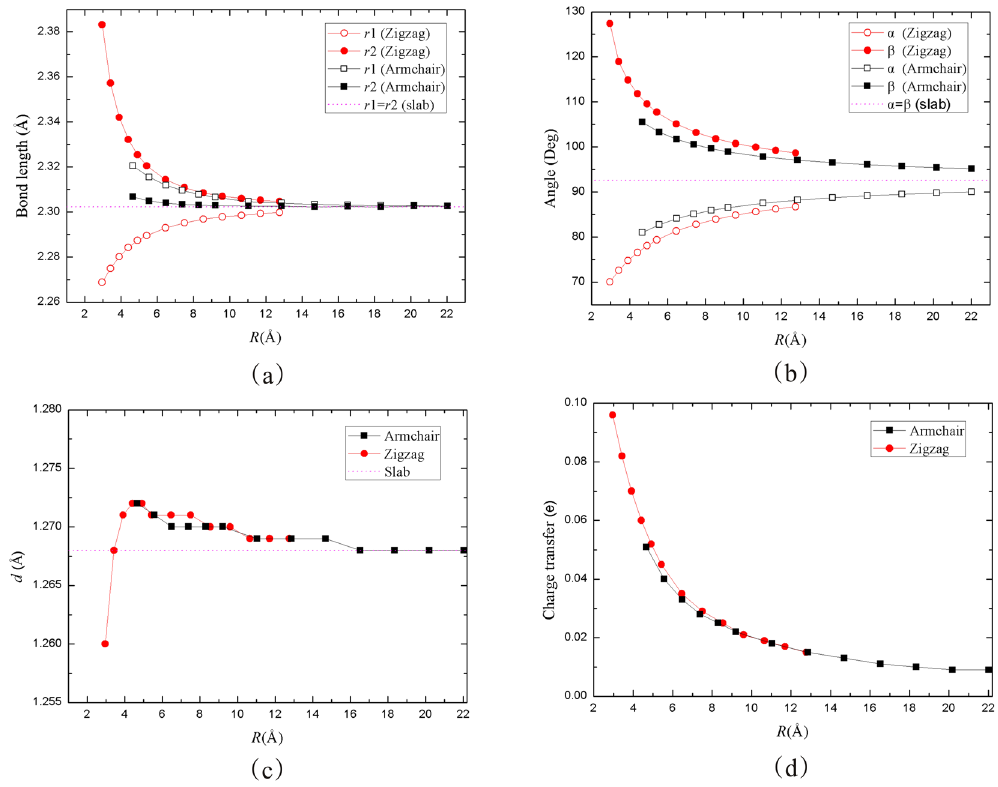
Figure 4. ( a ) Bond lengths of the armchair and zigzag blue PNTs are plotted versus tube radius. ( b ) Angles of two types of blue PNTs as a function of radius. ( c ) Dependence of puckered-layer distance d of blue PNTs with different radius. ( d ) The amount of charge transfer between P atoms in blue PNTs with different radius. The dashed horizontal line denotes the values of the corresponding blue phosphorene slab.